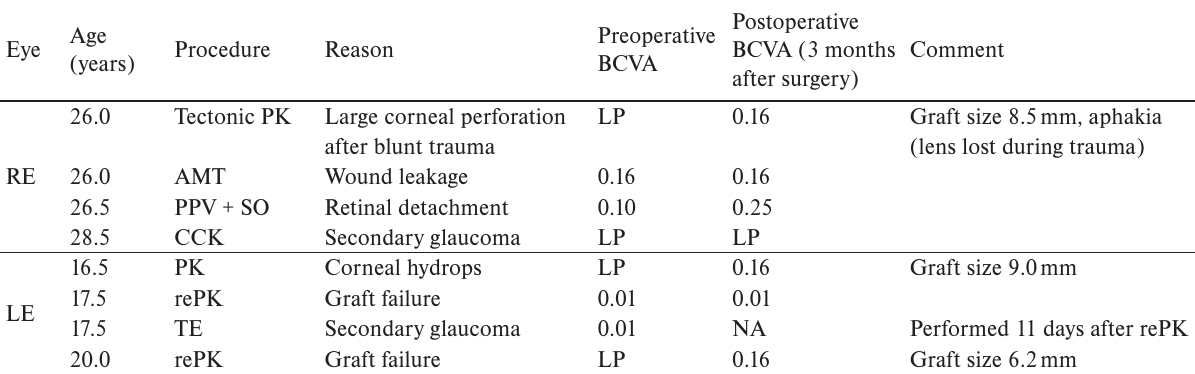
table 1. Ocular surgeries performed in the proband reviewed for 26 years.